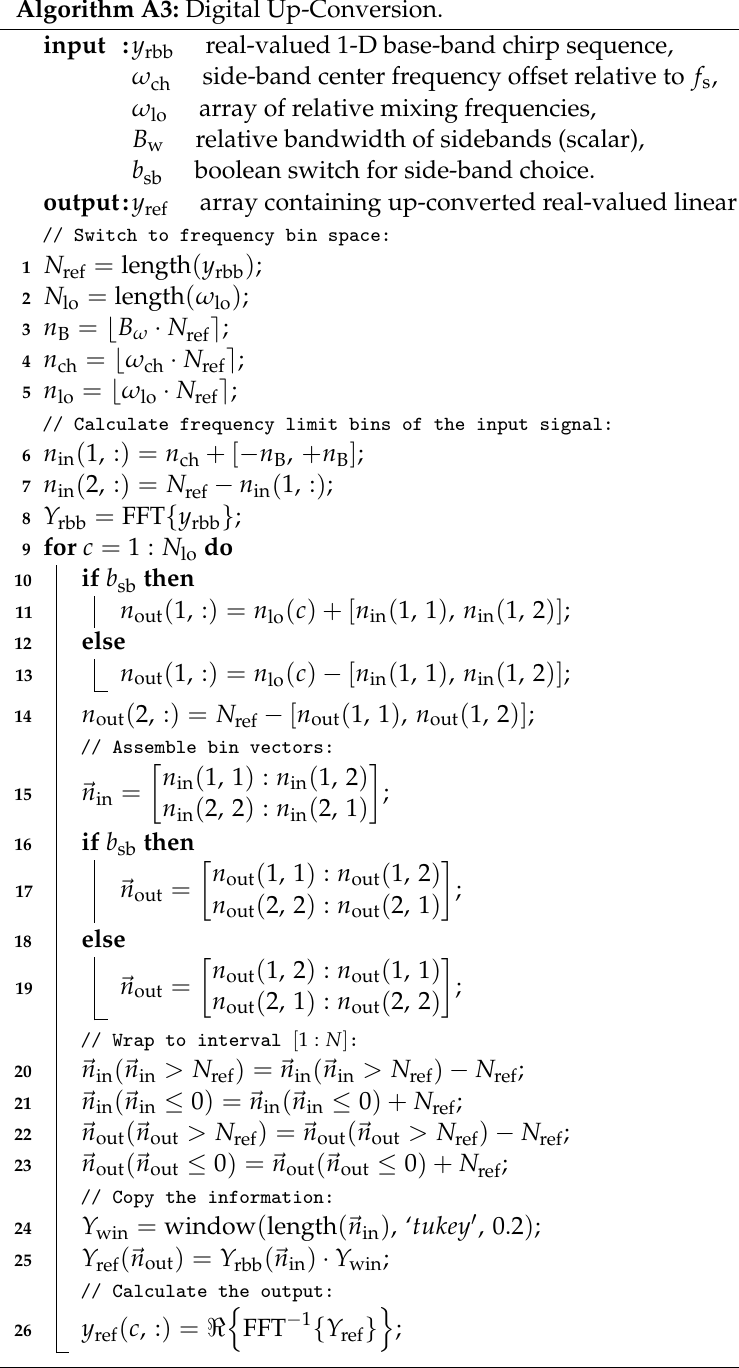
Algorithm A3: Digital